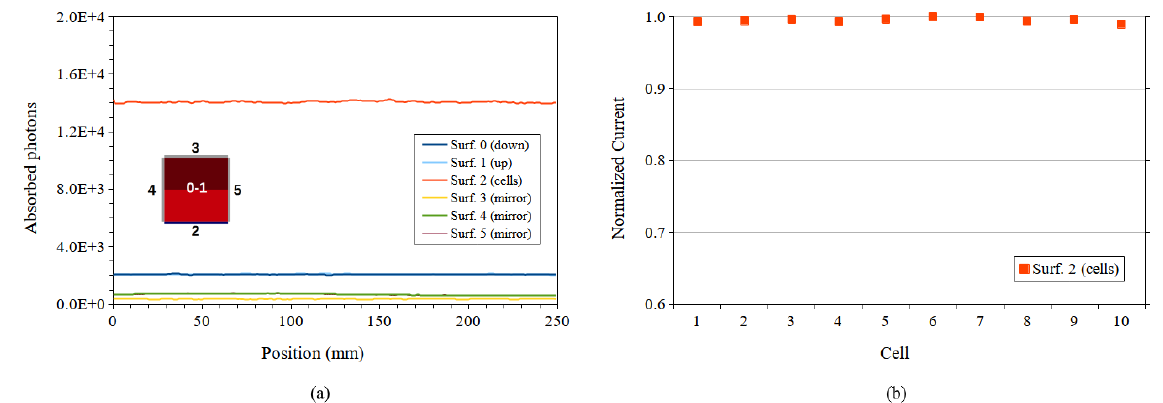
Figure 15. Shaded LSC panel with one 10-cells PV array, shading along the half surface opposed to the PV array: ( a ) Number of rays of light collected by the PV cells as a function of the position along the LSC side, which ranges from 0 mm to 250 mm. ( b ) Normalized current produced by each PV cell.